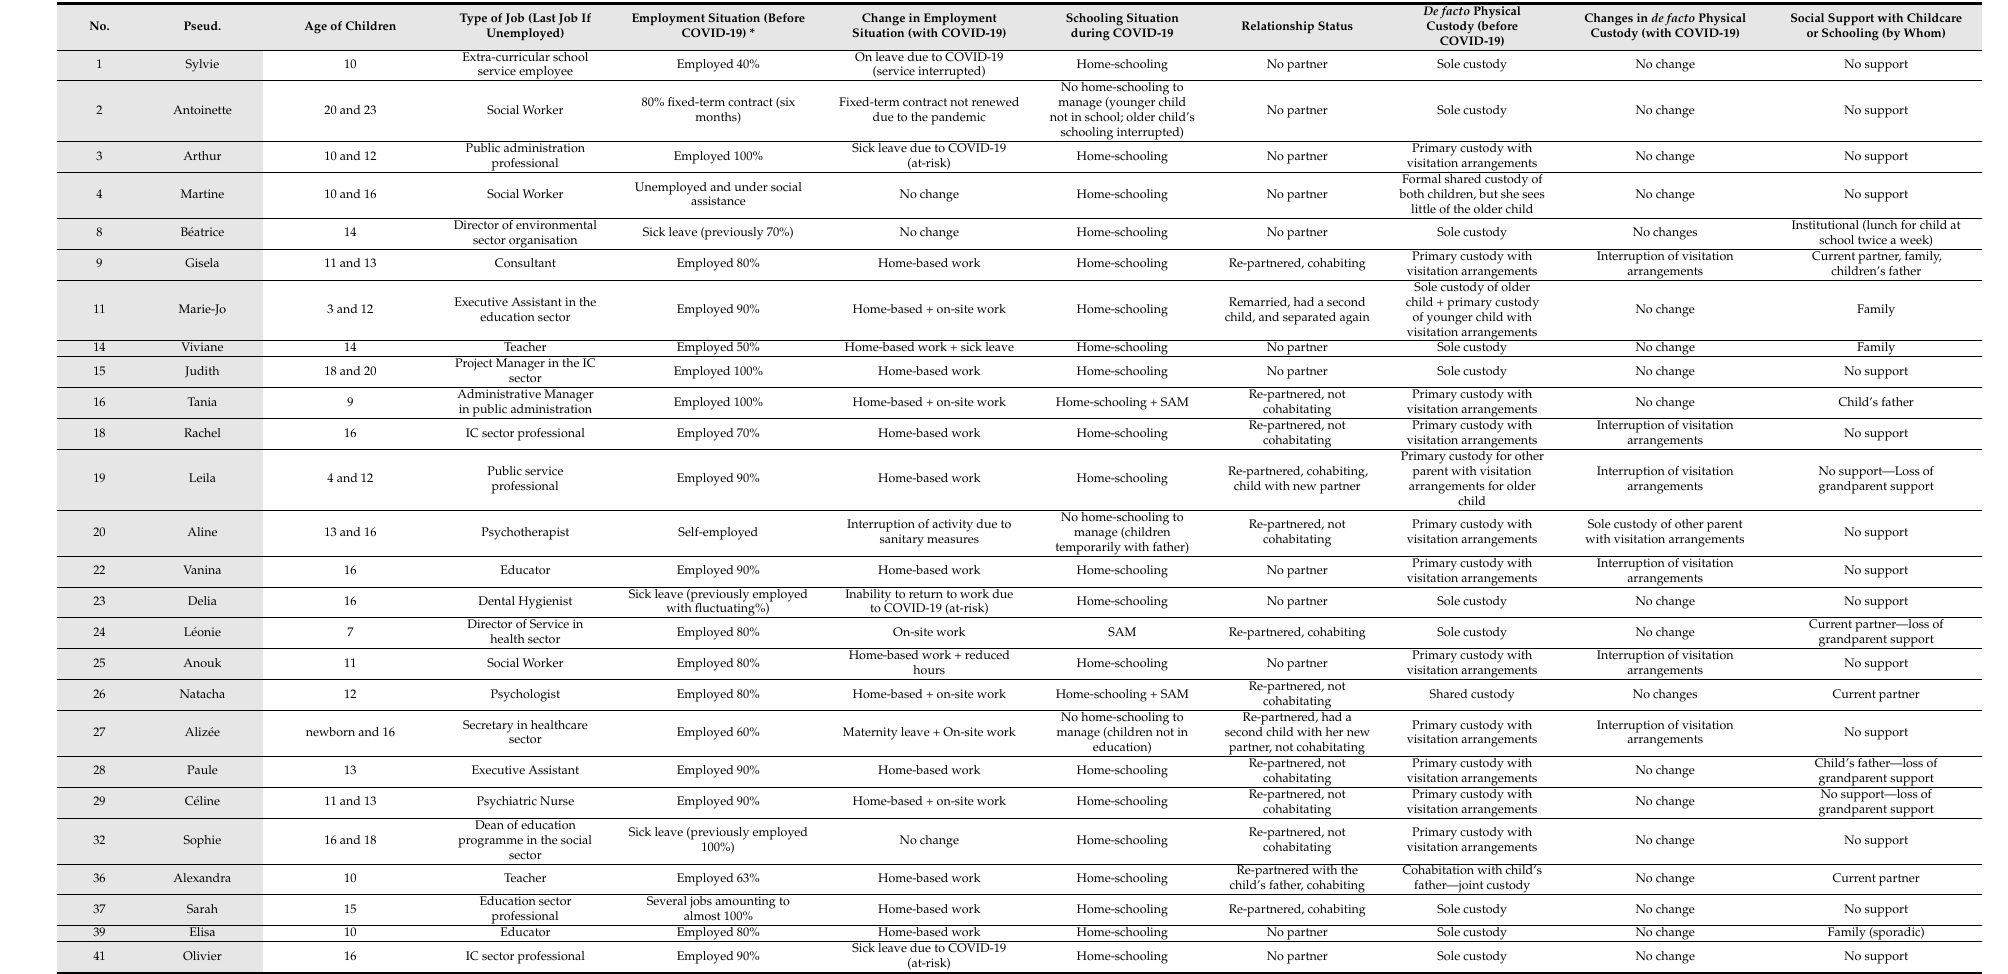
Table 1. Sample characteristics and changes in main life domains triggered by the